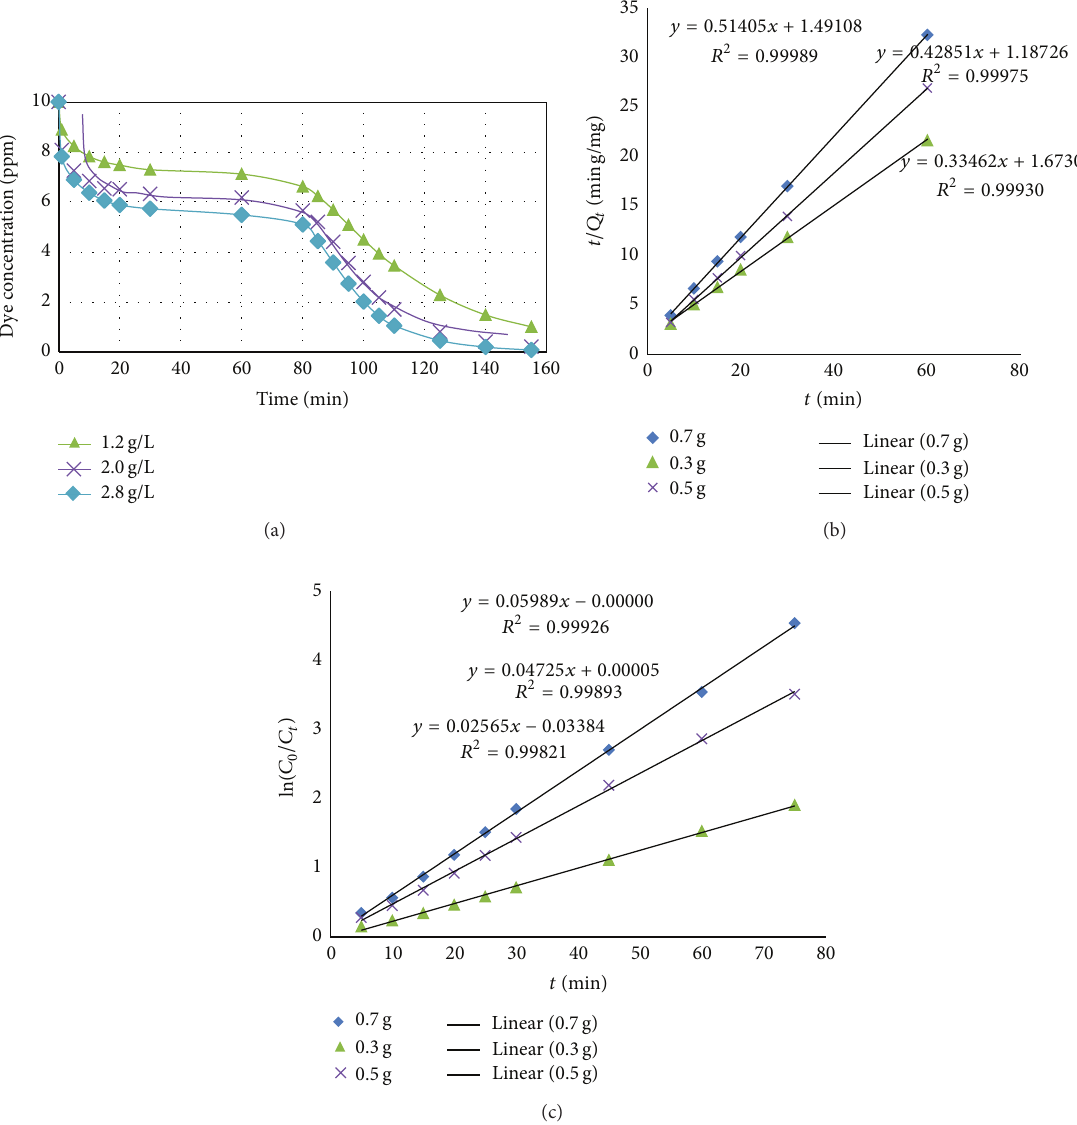
Figure 13: (a) Methyl orange adsorption-photodegradation curves by various dosages of photocatalyst composite; (b) the corresponding lin- earized plots of pseudo-second order adsorption kinetics; and (c) the corresponding linearized plots of pseudo-first order photodegradation